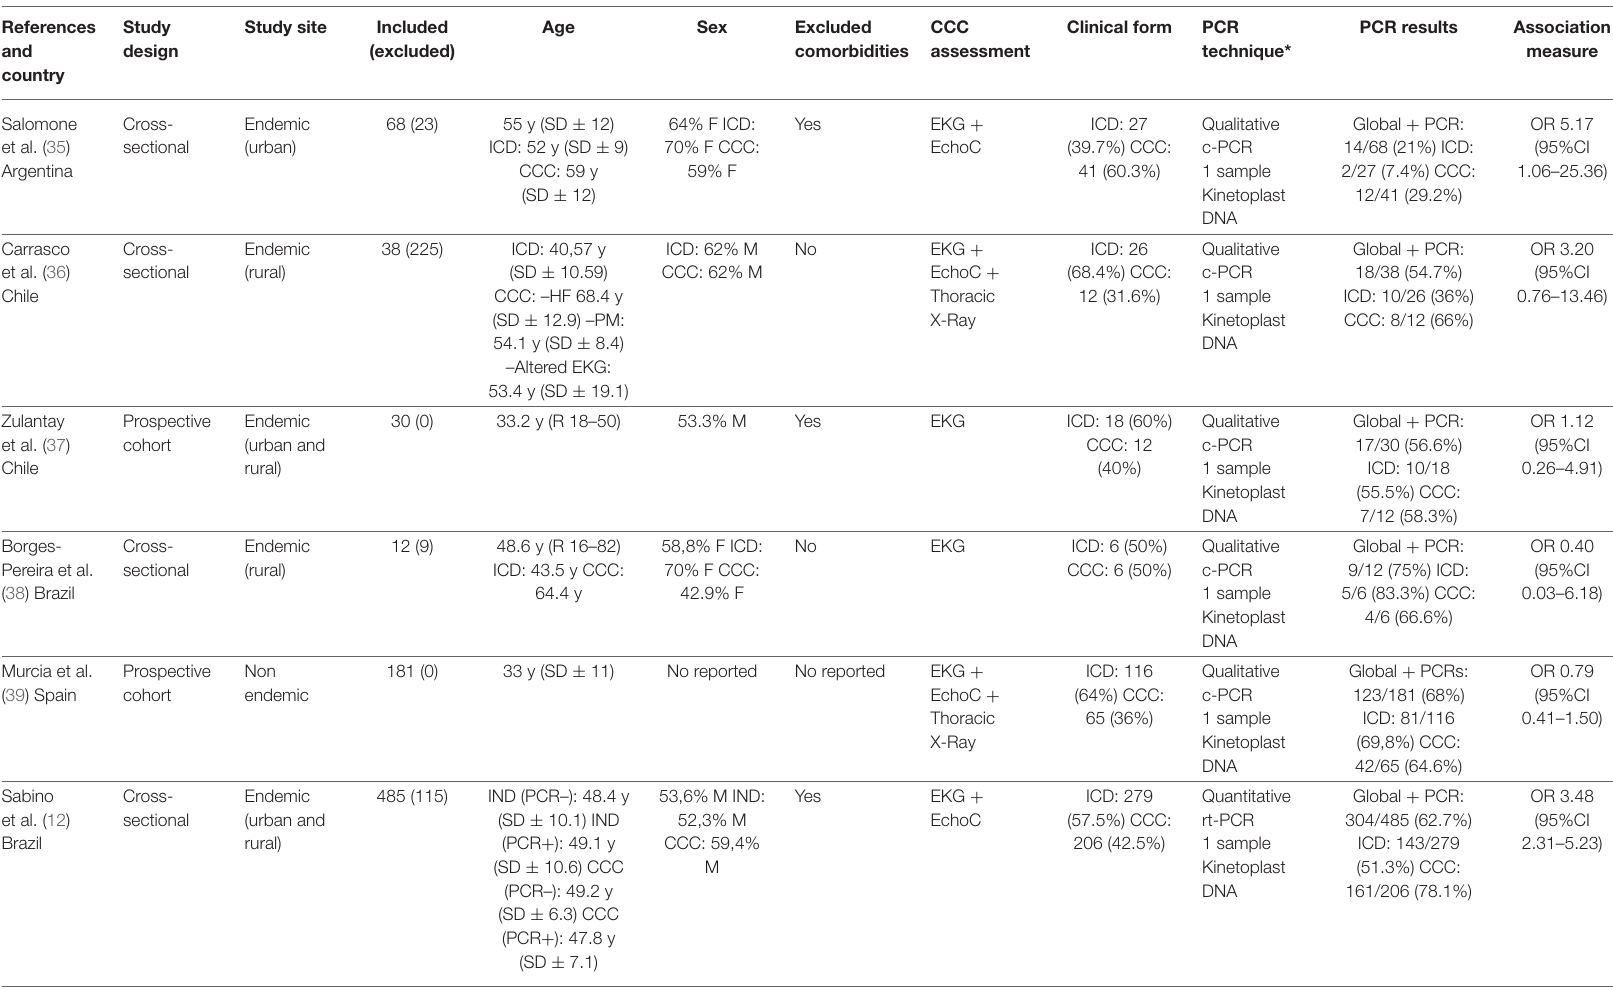
TABLE 1 | Summary of the characteristics of the included